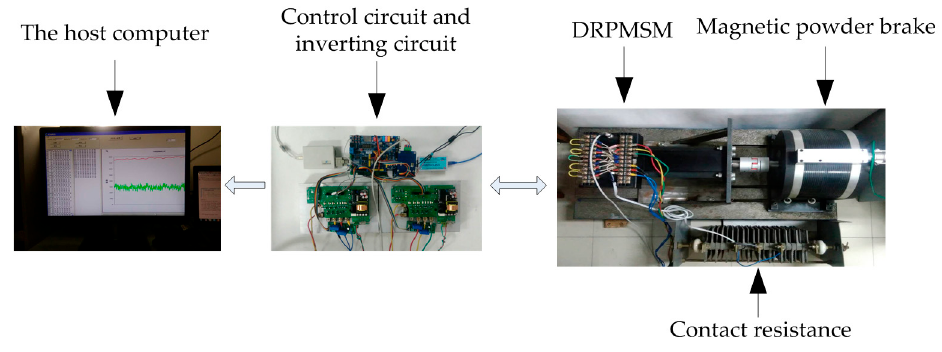
Figure 15. Experimental system diagram of DRPMSM.